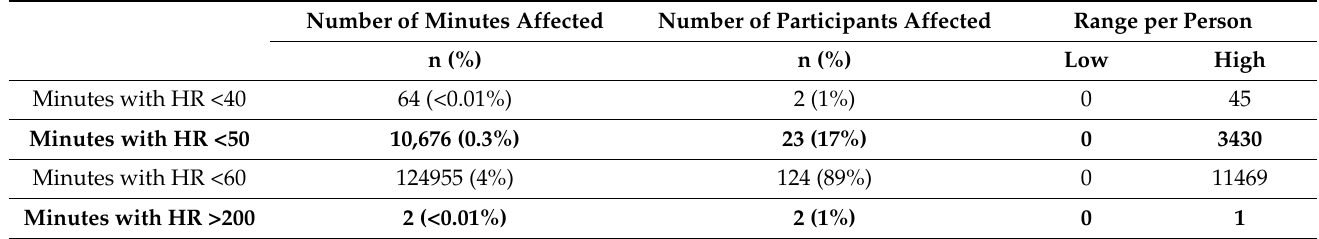
Table 3. Data exclusion based on aphysiologic signal—unlikely heart rate